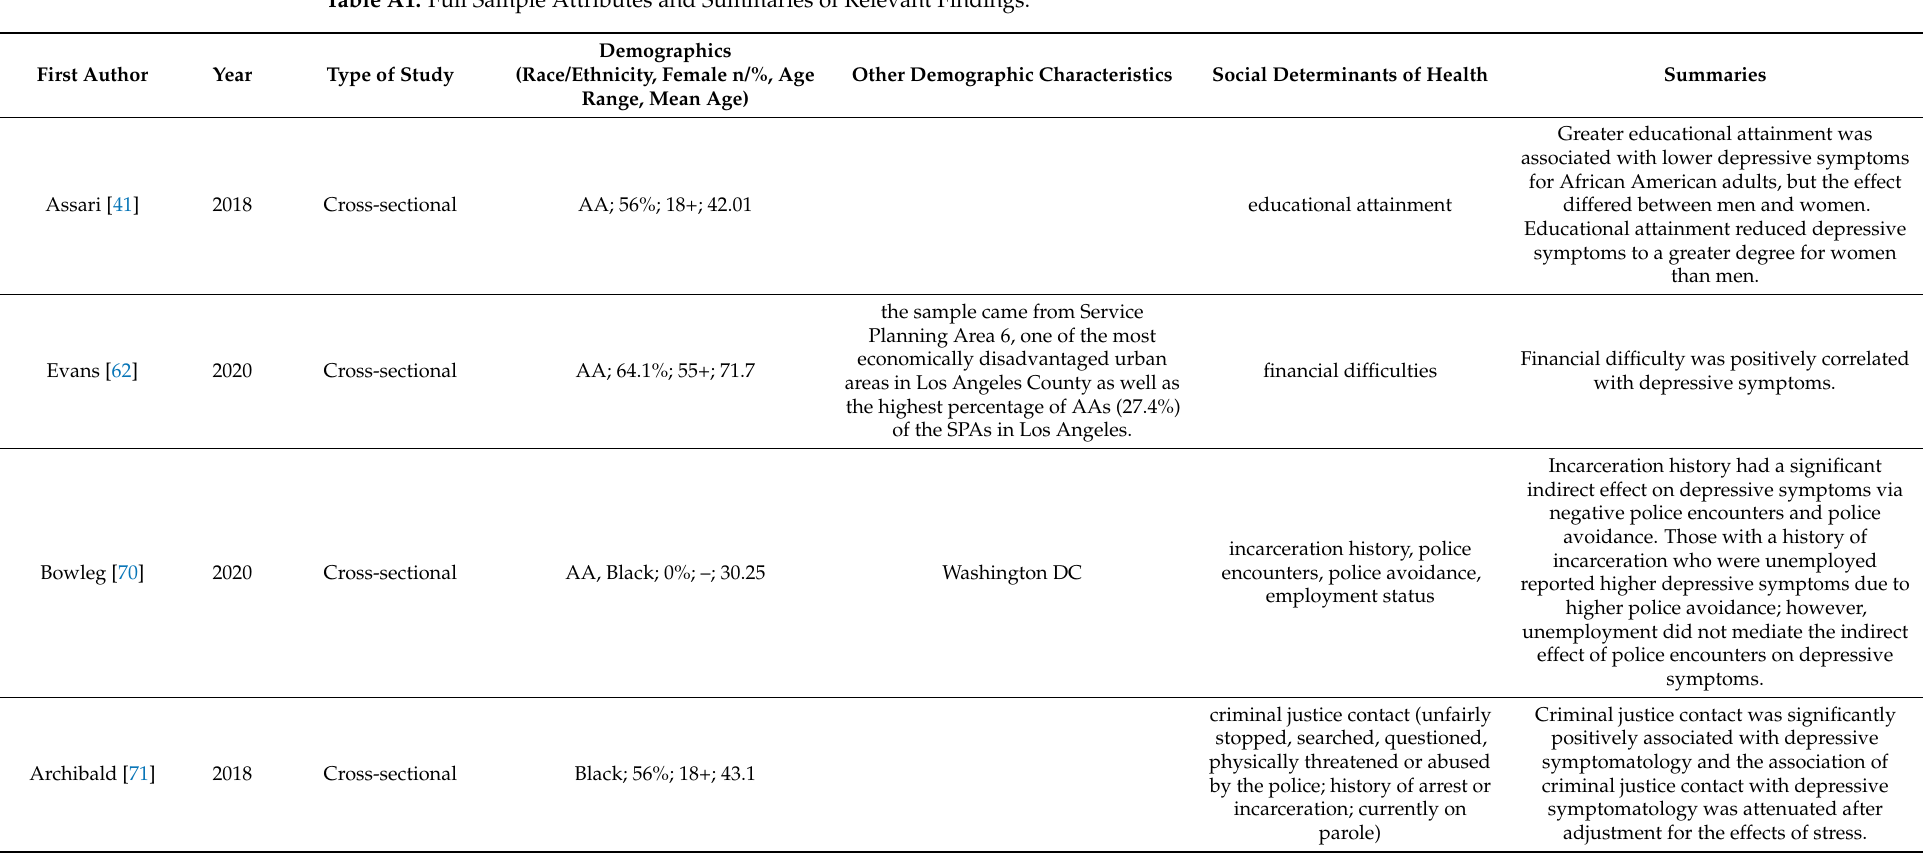
Table A1. Full Sample Attributes and Summaries of Relevant